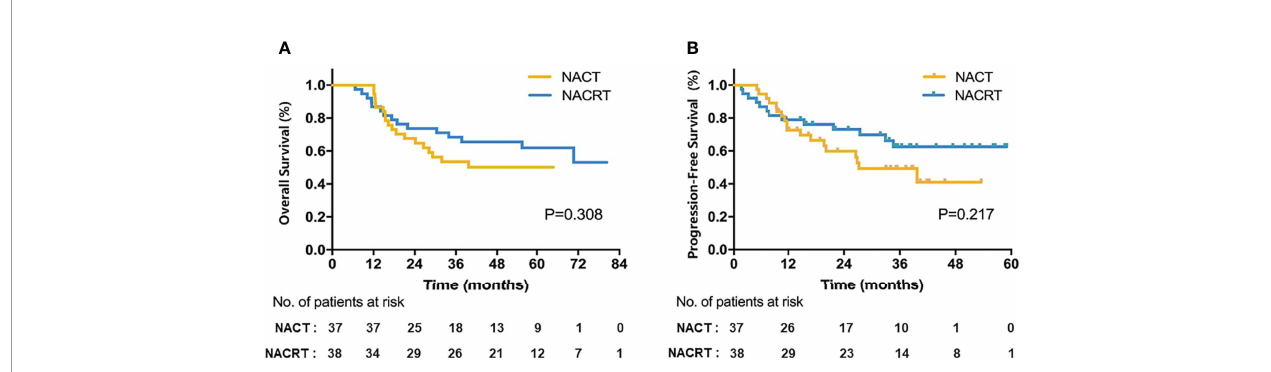
FIGURE 2 | Survival of the NACT and NACRT groups in the ITT population. (A) OS; (B) PFS.